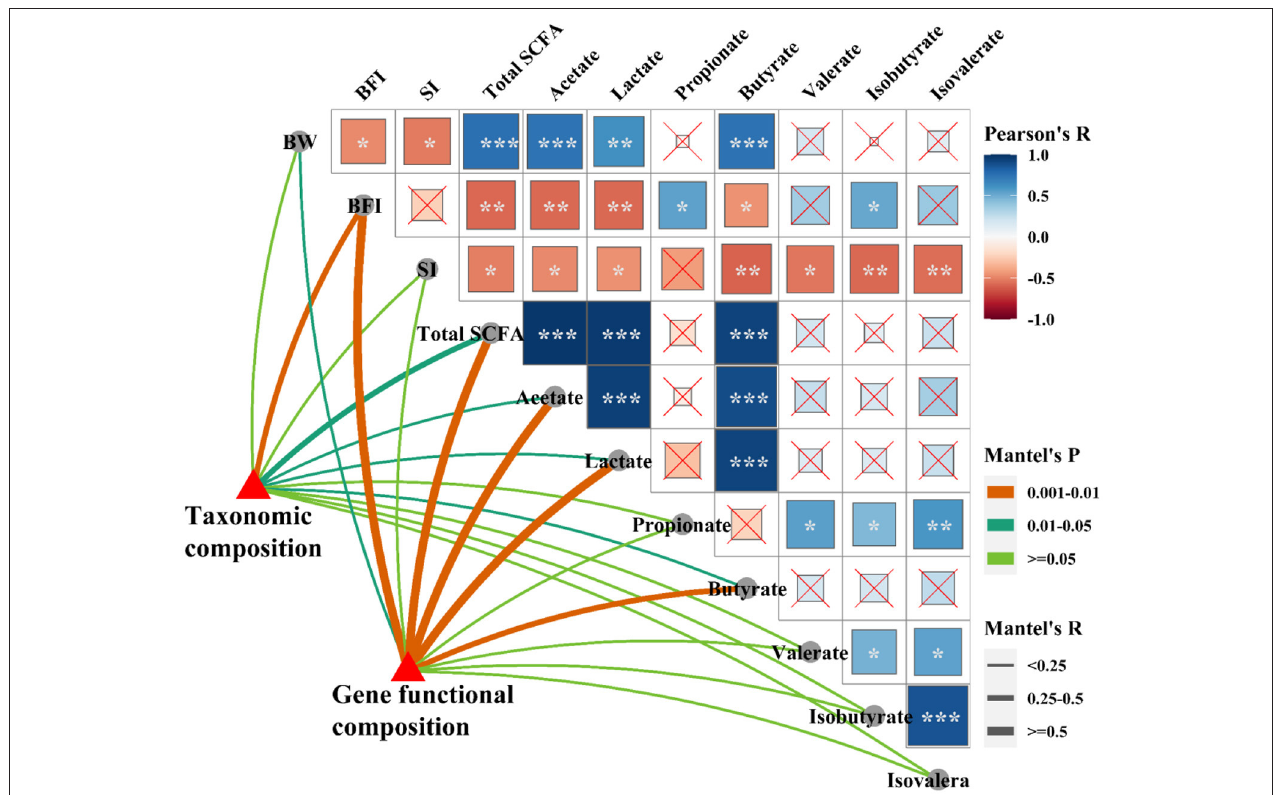
FIGURE 9 | Relationships among phenotypic variables, the microbial community, and metabolic functional composition. Pairwise comparisons of phenotypic variables with a color gradient denoting Pearson correlation coefficient. Taxonomic and functional community structures were related to each phenotypic variable by Mantel correlation (based on Bray-Curtis dissimilarity). The edge width represents the Mantel’s r statistic for the corresponding distance correlations, and edge color denotes the statistical significance. * p < 0.05; ** p < 0.01; *** p <